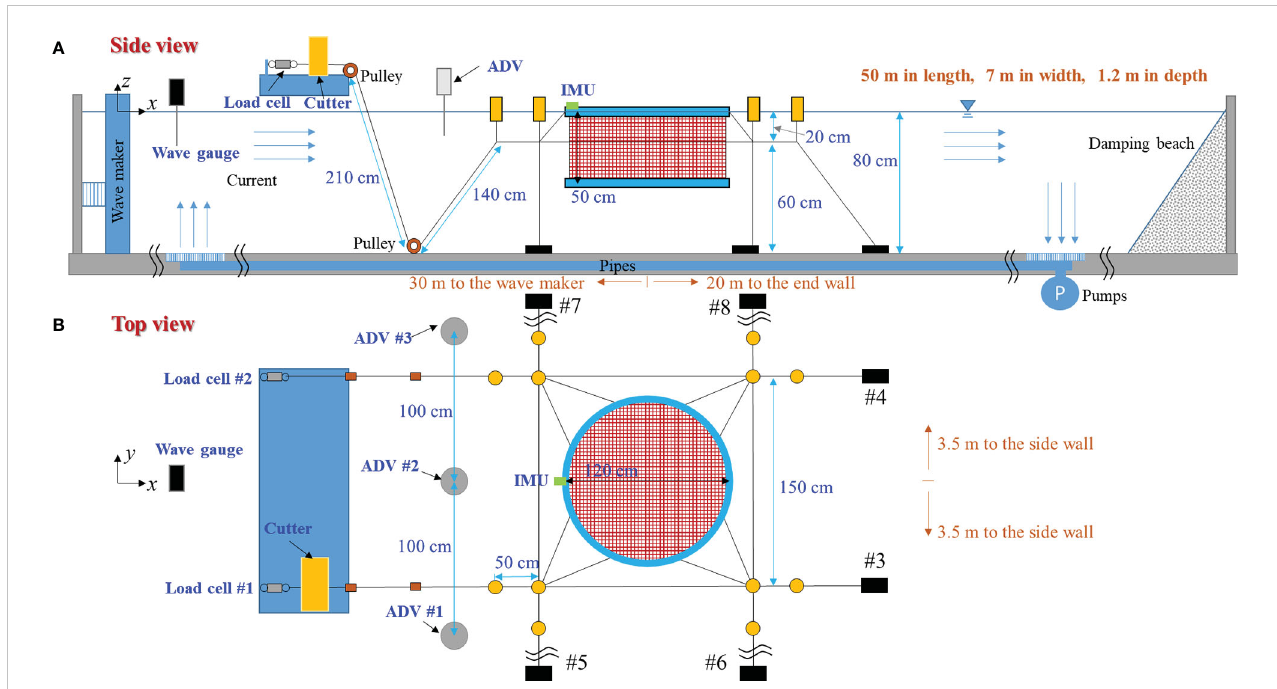
FIGURE 2 Schematic diagram of the model test.